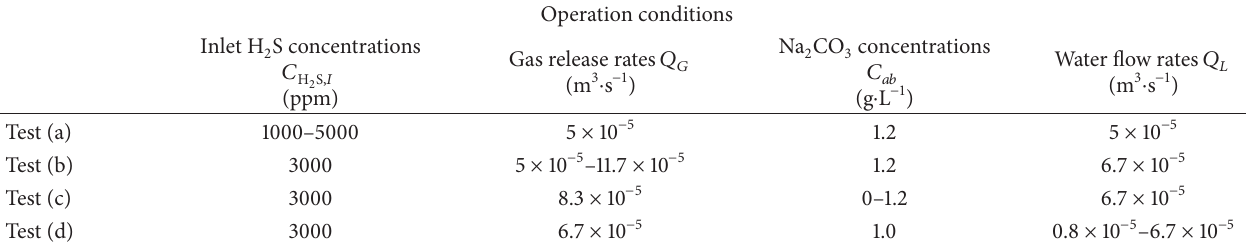
Table 2: Experimental conditions for parameters tests (one-nozzle set). Operation